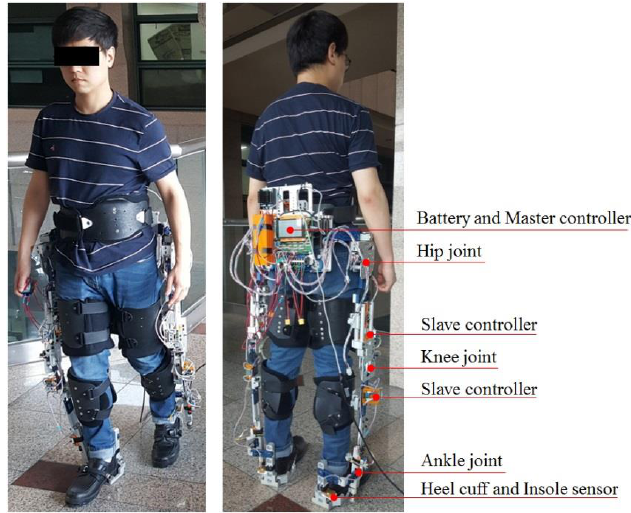
Figure 1. Subject wearing the lower limb exoskeleton and main configuration of the system.